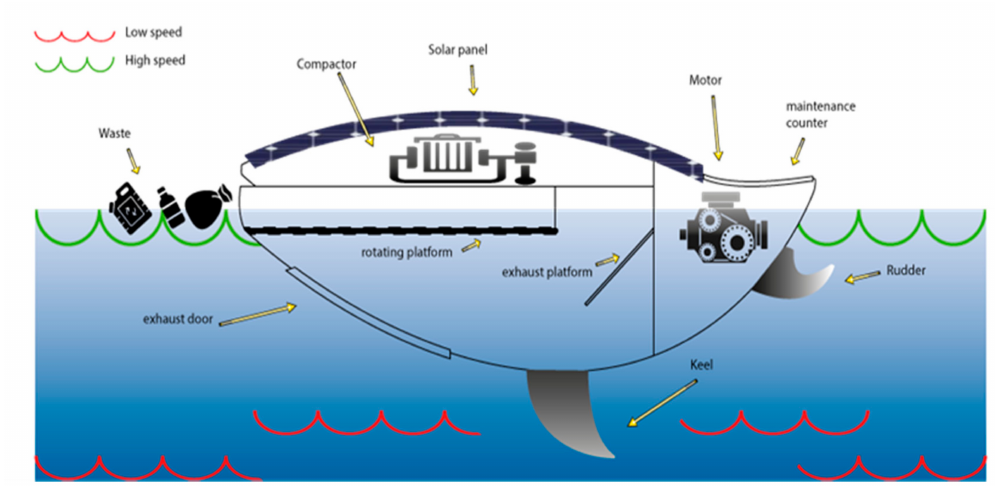
Figure 5. Product Architecture.